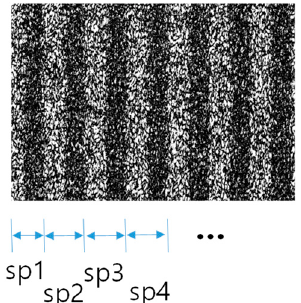
Figure A1. Reconstructed hologram image at 80 mm depth (brightness level is enhanced for clear presentation).